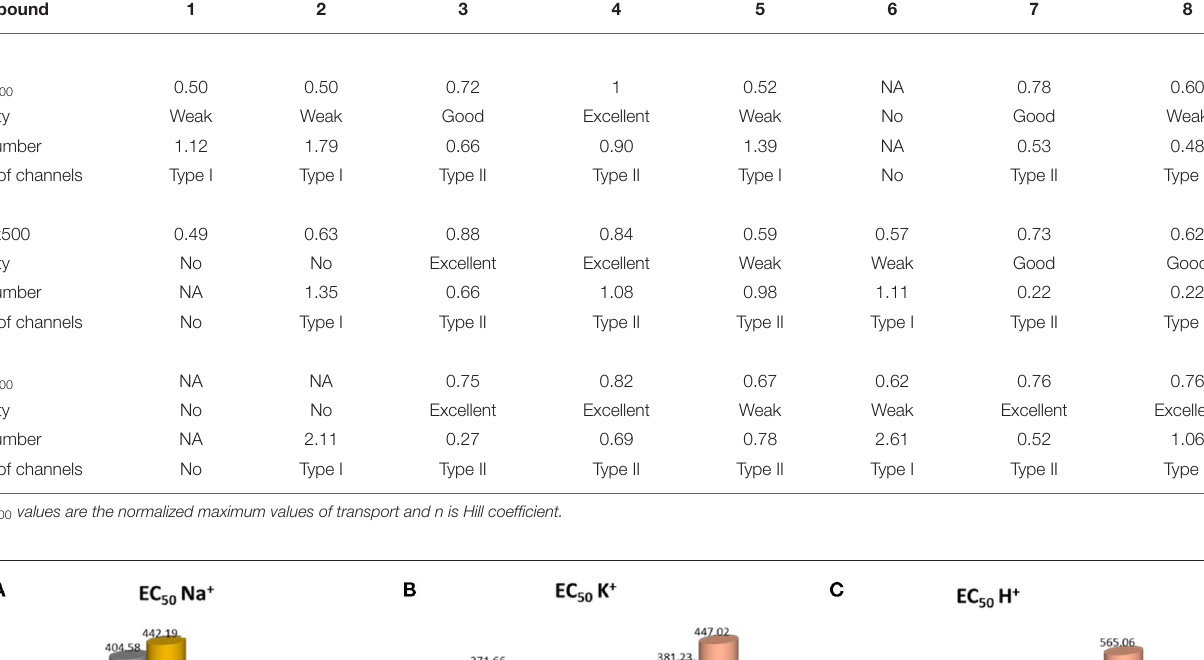
initial rate of transport, and the experimental one we can differentiate between ideal and practical conditions, concluding that the read experimental activity is